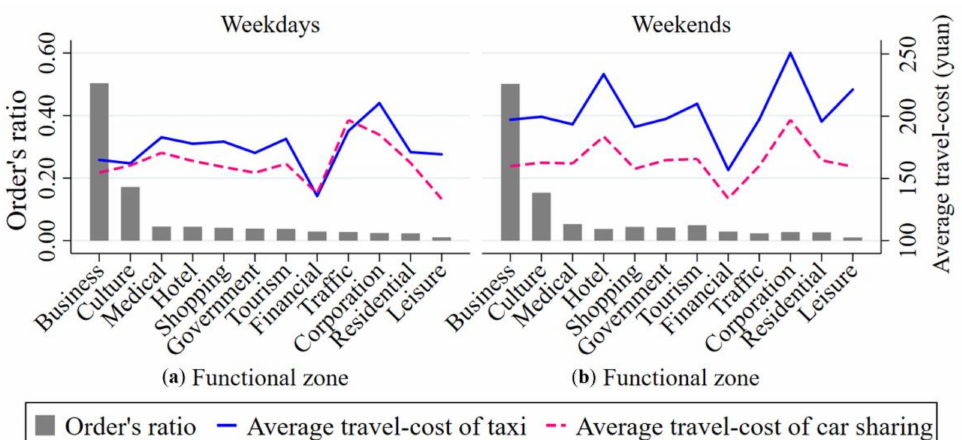
Figure 16. Comparison of travel-cost between taxis and car sharing for each functional zone on weekdays ( a ) and on weekends ( b